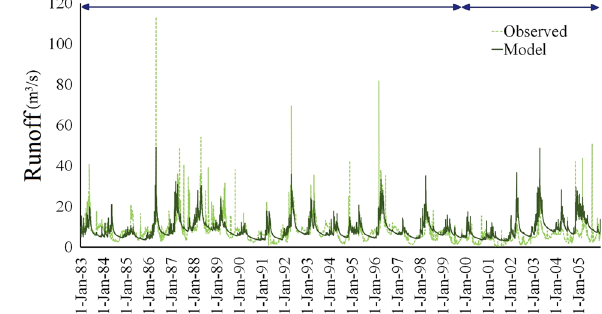
Fig. 5 Future projections (2025–2048) compared to the baseline period: a Tmin b Tmax c PCP under scenarios (RCP4.5 and RCP8.5) in whole watershed